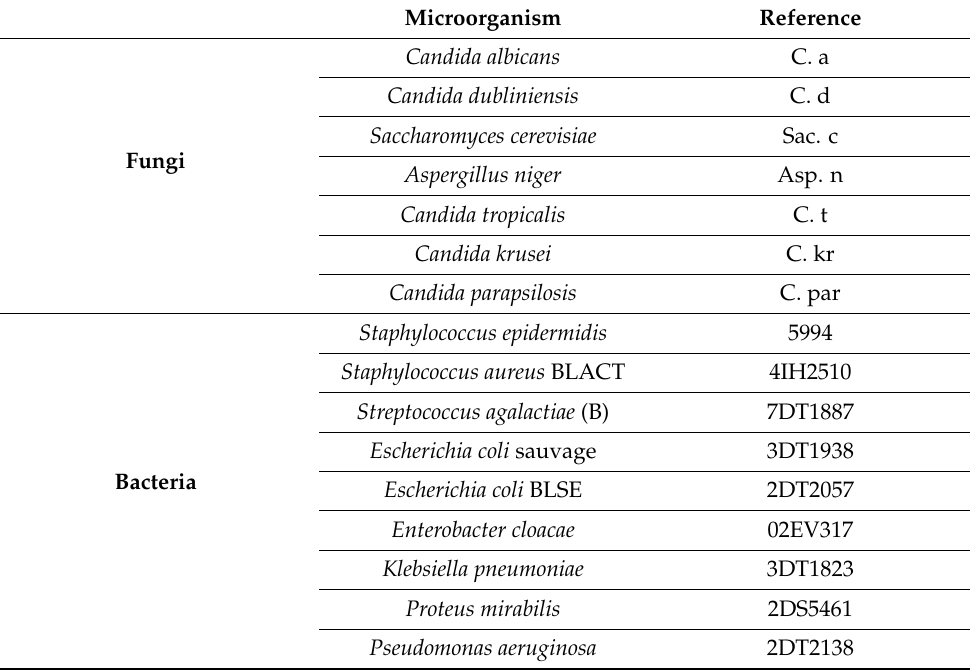
Table 1. The test microorganisms used in this study.